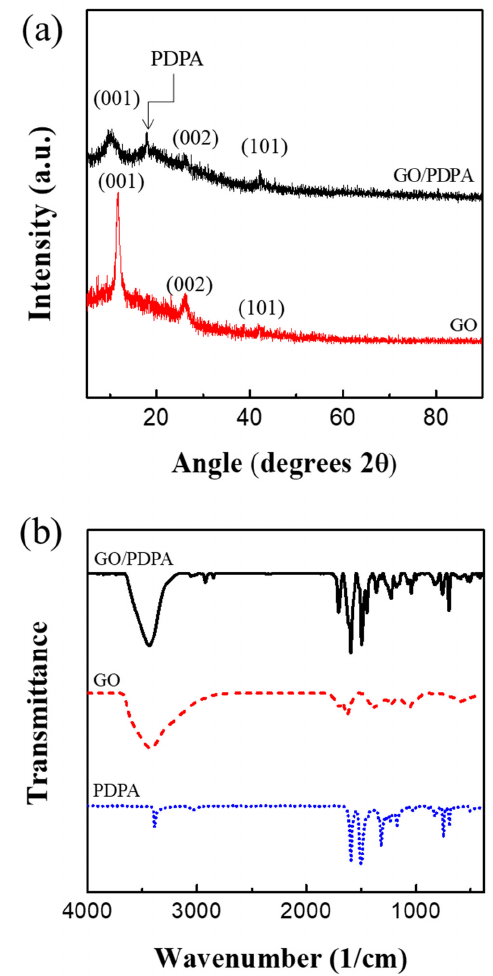
Figure 3. ( a ) X-ray diffraction profiles, ( b ) FTIR data of pure GO, PDPA, and GO/PDPA microsheet composites.